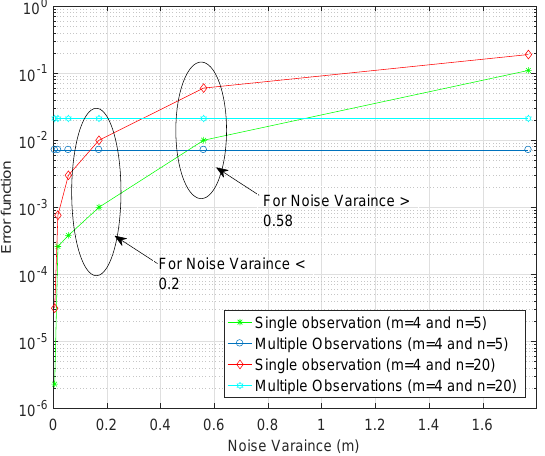
Figure 4. Error function vs. noise variance for single and multiple observations.